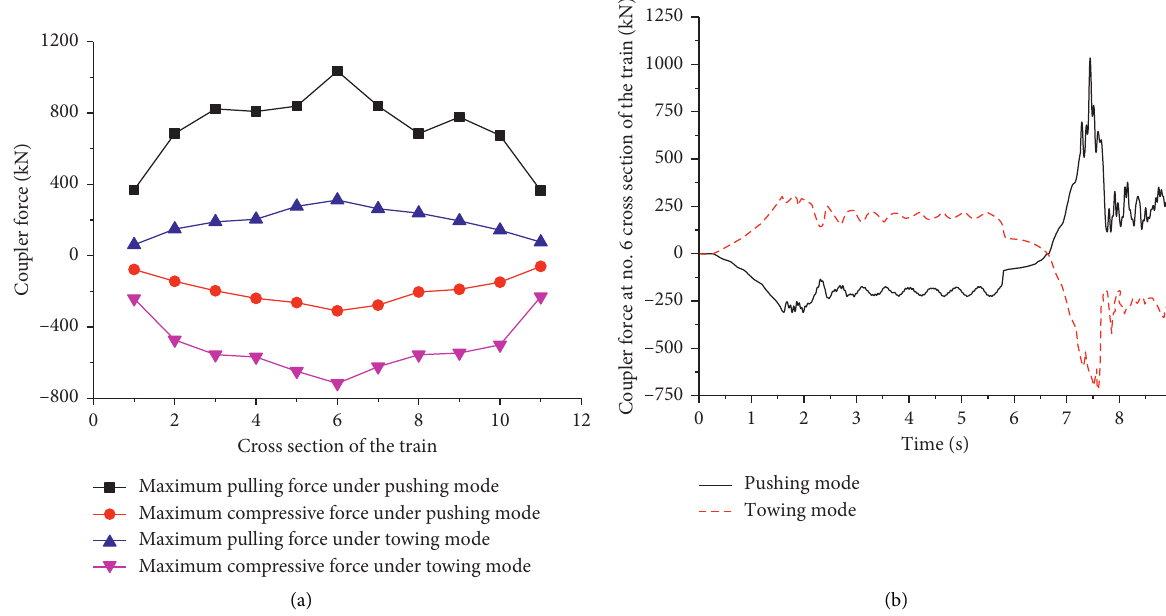
Figure 9: Coupler force when AW3 rescues AW3. (a) Maximum coupler forces. (b) Time history of coupler forces.